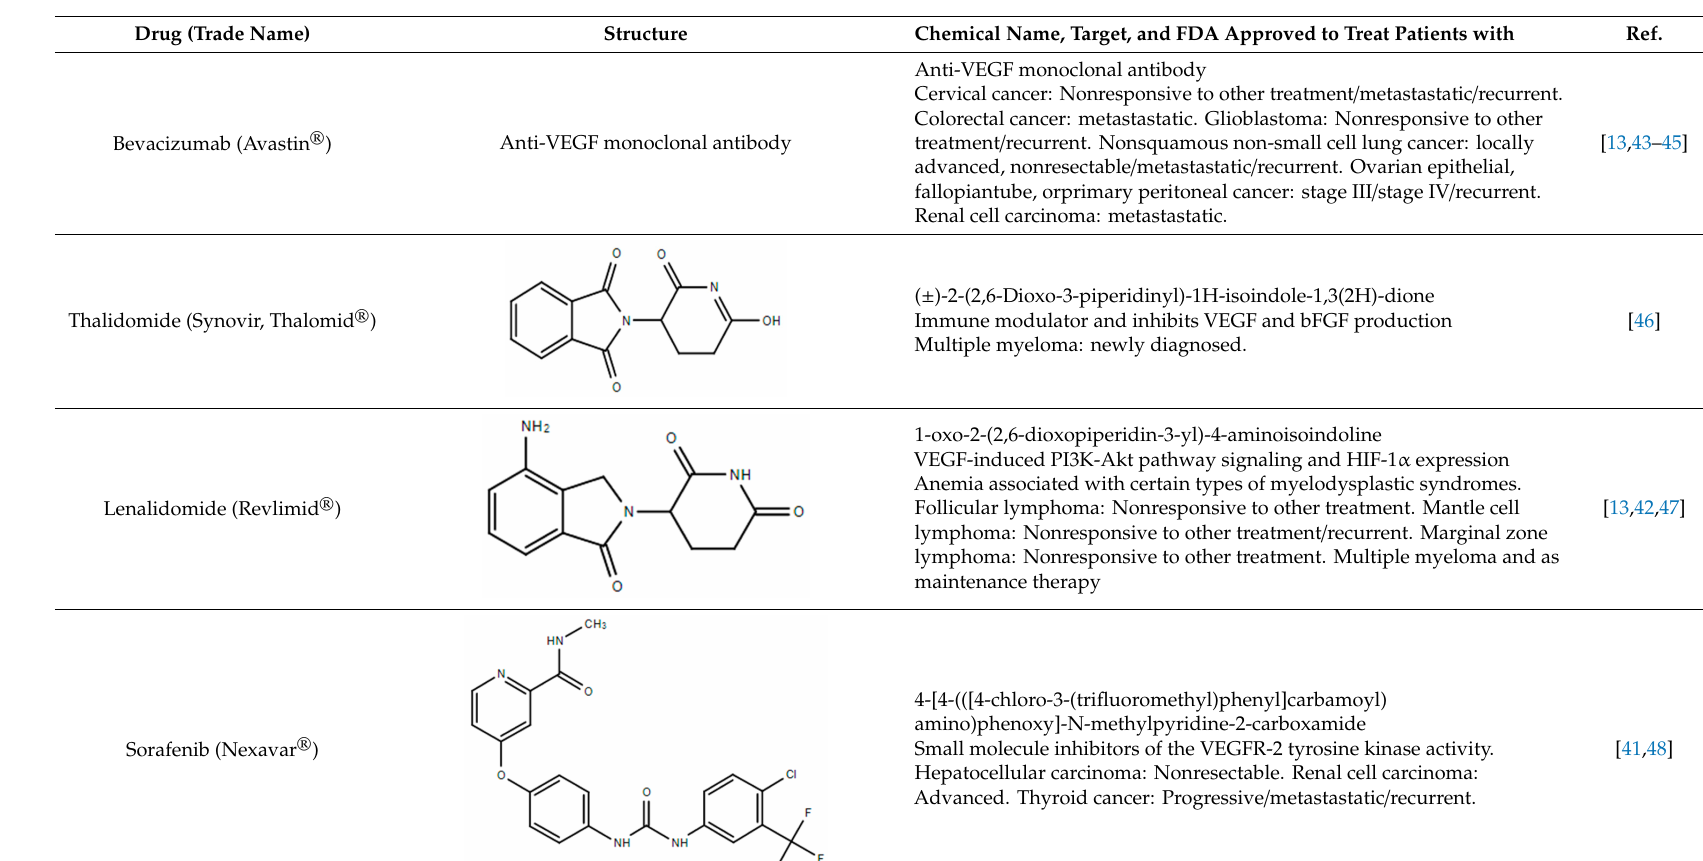
Table 1. FDA approved angiogenic inhibitors, trade name, chemical structures, target, and FDA and approved